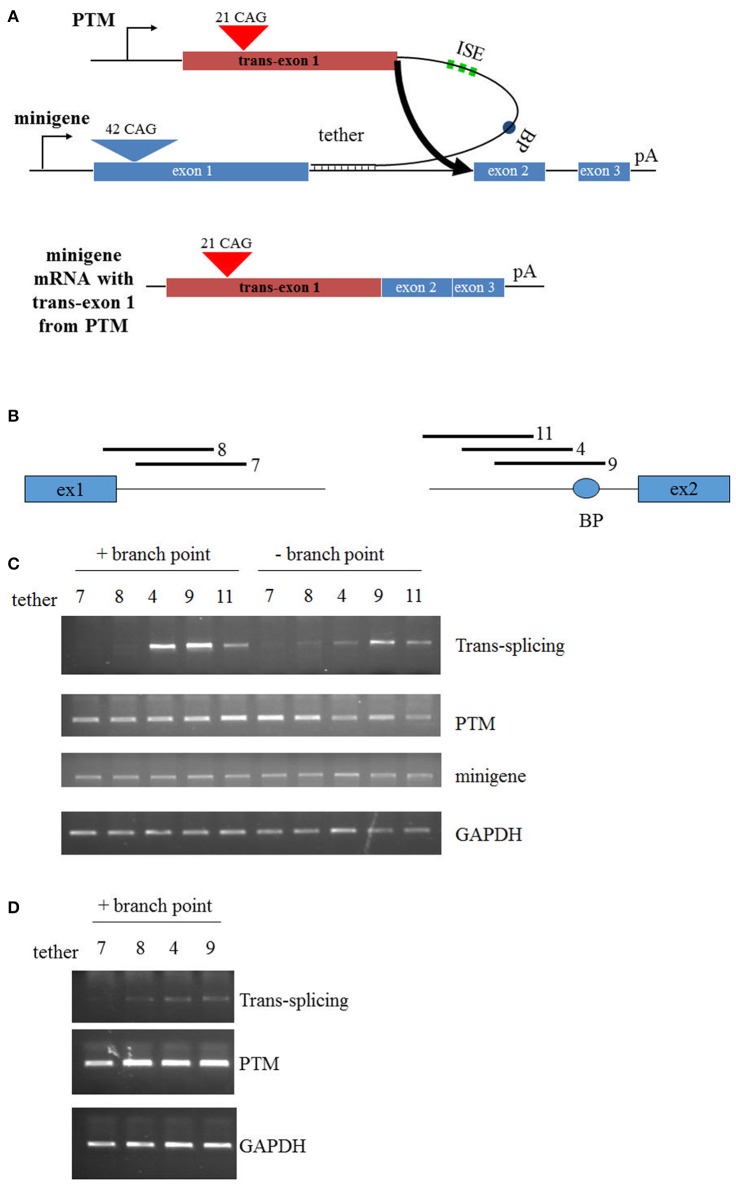
Trans-splicing in HEK293 cells. (A) Schematic of PTM targeting. The PTM is driven by the CMV promoter and contains 21 CAG repeats within HTT exon 1. The PTM contains intronic splice enhancers (ISE), a branch point (BP), and a “tether” that targets the PTM to specific sequences within the HTT or mini-gene pre-mRNA. The HTT mini-gene is driven by the CMV promoter and consists of exon1-2-3 with intervening introns and a polyA signal. (B) Relative position of the PTM tethering elements for the PTMs. T7 and T8 target the 5′ end of intron 1; T4, T9, and T11 target the 3′ end of intron 1. (C) Mini-gene trans-splicing in HEK293 cells. RT-PCR of total RNA isolated from HEK293 cells transiently transfected with the indicated PTMs and the HTT mini-gene. PTMs contained a splicing branch point (+branch point) or had the branch point removed with flanking restriction sites (−branch point). trans-splicing RNA, PTM expression, mini-gene expression, and endogenous GAPDH expression is shown. (D) Endogenous trans-splicing in HEK293 cells. RT-PCR of total RNA isolated from HEK293 cells transiently transfected with the indicated PTMs. trans-splicing RNA, PTM expression, and endogenous GAPDH expression is shown.